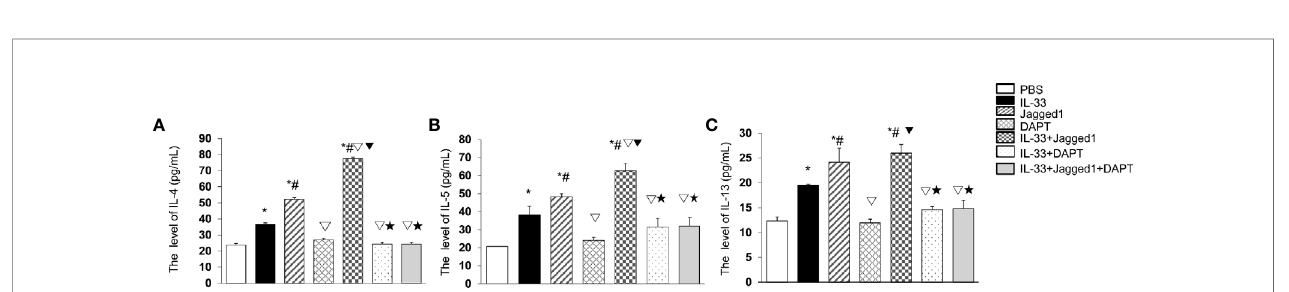
FIGURE 5 | Cytokines after IL-33, Jagged 1 and DATP treatment. Level of (A) IL-4, (B) IL-5 and (C) IL-13 in the supernatant of PBS group, IL-33 stimulation group, Jagged 1 treatment group, DAPT treatment group, IL-33 + Jagged 1 treatment group, IL-33 + DAPT treatment group were detected by ELISA. Data are shown as mean ± SEM. n = 10. * P < 0.05 compared with PBS group, # P < 0.05 compared with IL-33 group, ▽ P < 0.05 compared with Jagged1 group, ▼ P < 0.05 compared with DATP group, ★ P < 0.05 compared with IL-33+Jagged1